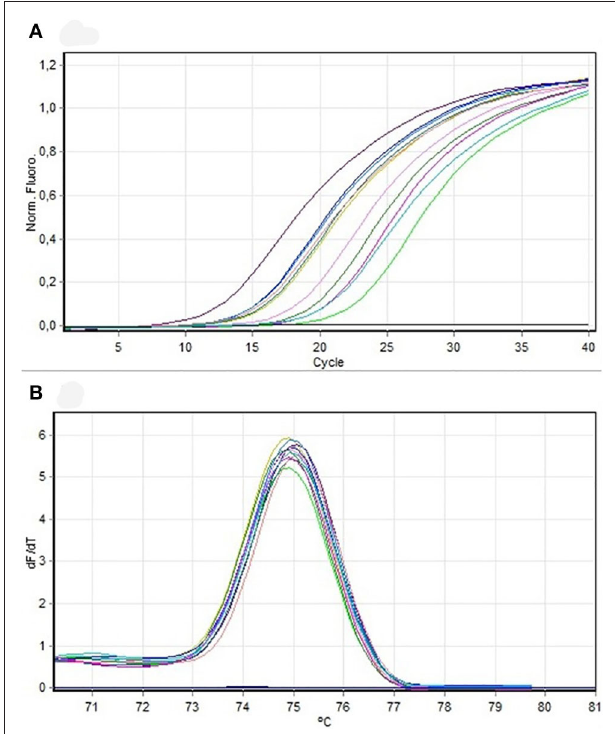
FIGURE 5 | (A) Amplification curve. PCR mecA samples to be sequenced. (B) Dissociation curve. PCR mecA samples to be